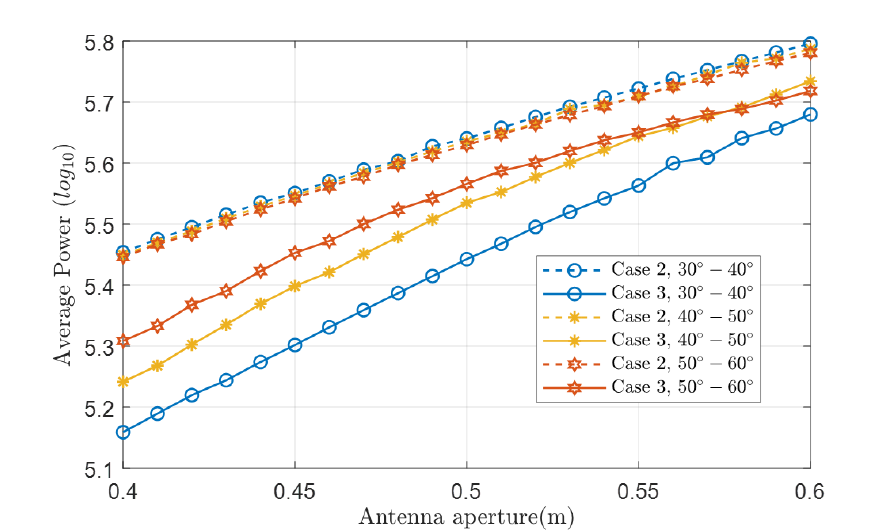
Figure 12. The average received power comparison of Case 2 and Case 3.